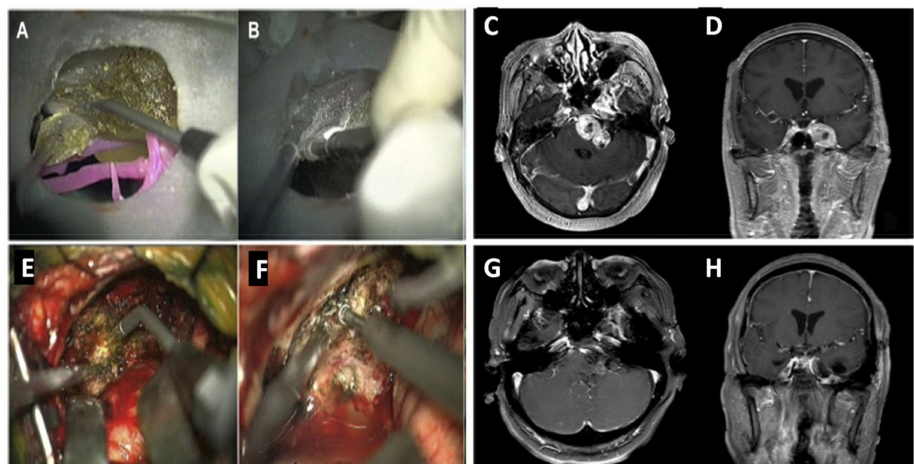
Figure 1. Simulated surgery and intraoperative scenario. ( A )Three-dimensional tumor model resec- tion using left subtemporal keyhole approach and laser-knife. ( B ) Surgical simulation of removing the residual tumor on the 3D model from the petrous apex after rotation. ( C ) MRI scan at transverse position displaying tumor growth through middle-posterior cranial fossa preoperation. ( D ) Tumor observed in the coronal position, preoperation. ( E ) Real-patient tumor removal with laser-knife. ( F ) Intraoperation grinding of the petrous apexin. ( G ) Postoperation MRI scan showing no residual tumor after surgery in transverse view. ( H ) Coronal position confirming no tumor remaining post operation